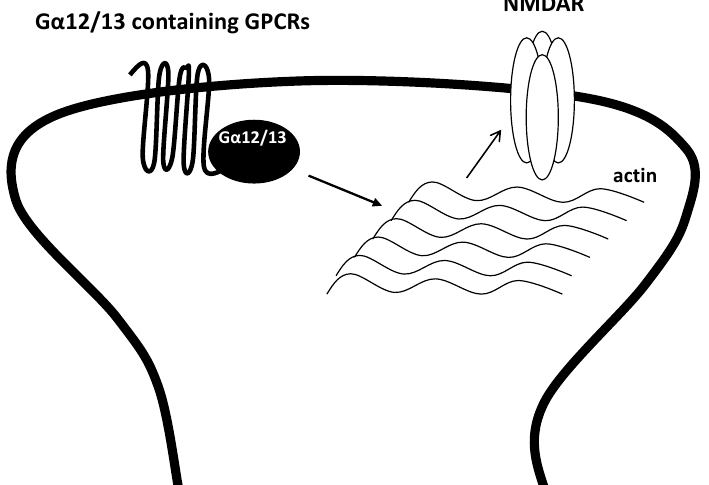
Figure 4. Gα coupled GPCRs can modulate NMDARs indirectly via their effects on 12/13 actin cytoskeleton